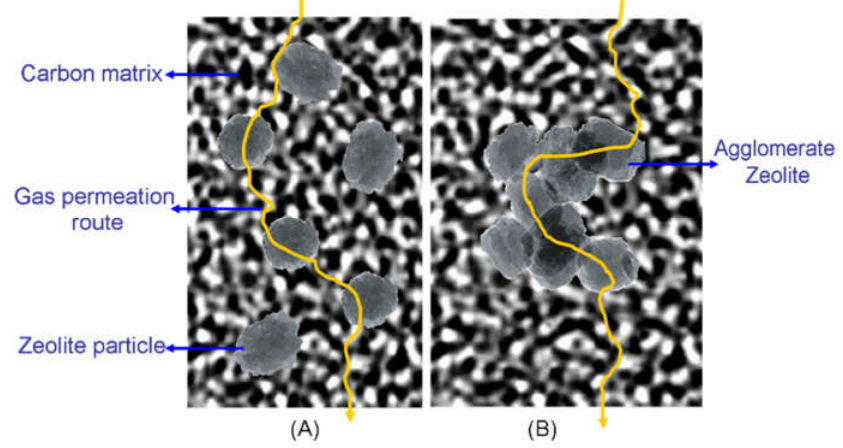
Figure 13. The model of the gas pathway through the zeolite/C hybrid membranes [59]. ( A ) well dispersed zeolite particles in the carbon matrix; ( B ) agglomerate zeolites in the carbon matrix.